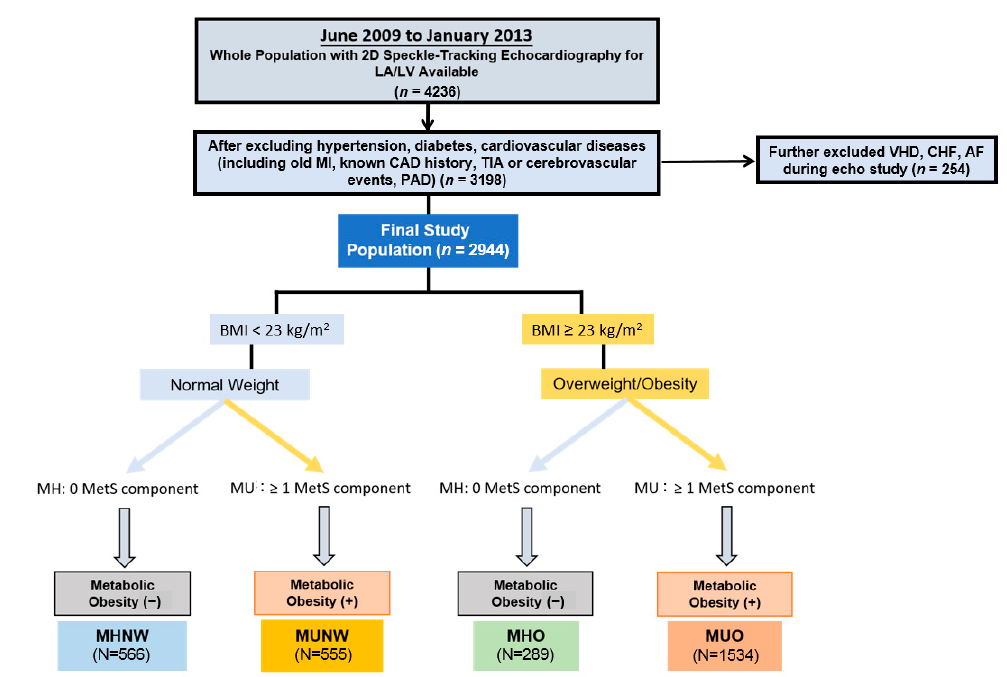
Figure 1. Study design and exclusion flowchart. Abbreviations: MI, myocardial infarction; CAD, coronary artery disease; TIA, transient ischemic attack; PAD, peripheral arterial disease; VHD, valvular heart disease; CHF, congestive heart failure; MetS, metabolic syndrome; MU, metabolically-unhealthy; MHNW, metabolically-healthy normal weight; MUNW, metabolically-unhealthy normal-weight; MHO, metabolically-healthy overweight/obese; MUO, metabolically-unhealthy